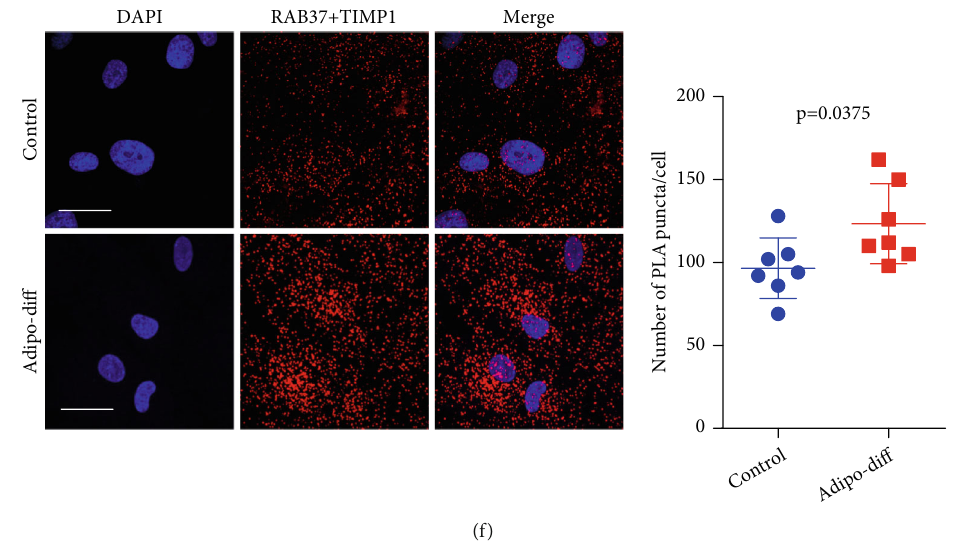
Figure 3: RAB37 promotes secretion of TIMP1: (a) schematic of the screening strategy for upregulated cytokines in RAB37-mediated adipogenic di ff erentiation of hADSCs; (b) fold changes of upregulated cytokines; (c) ELISA was performed to evaluate the concentration of TIMP1 in the supernatant of hADSCs during adipogenic di ff erentiation ( n = 6 ); (d) relative protein amount of RAB37 was determined by western blotting, n = 3 ; (e) correlation analysis between the relative protein amount of RAB37 and the concentration of TIMP1 calculated using Pearson analysis; (f) proximity ligation assay (PLA) was used to examine the interaction between RAB37 and TIMP1 on day 5 of adipogenic di ff erentiation. Scale bar = 50 μ m . Eight random views were counted, n = 8